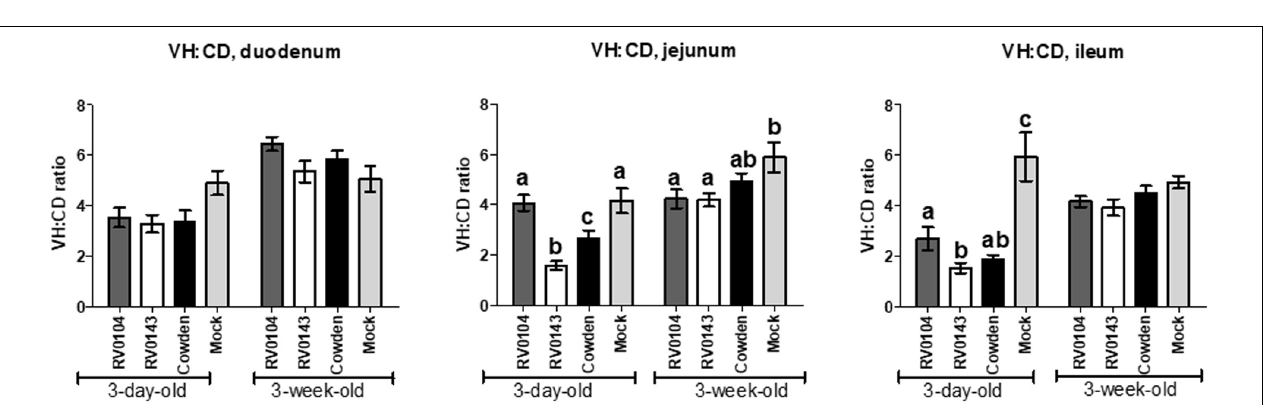
FIGURE 3 | PRVC serum geometric mean IgA antibody titers. (A) 3-day-old Gn piglets were inoculated with 10 5 RNA copy/ml of porcine PRVC Cowden ( n = 5), RV0104 ( n = 7), RV0143, ( n = 7) or mock ( n = 4). (B) 3-week-old Gn piglets were inoculated with 10 5 RNA copy/ml of porcine RVC Cowden ( n = 5), RV0104 ( n = 7), RV0143 ( n = 7) or mock ( n = 3). Serum was collected 5 days pre-inoculation (-5PID) and three times post PRVC inoculation (3PID, 5PID, and 10 PID).